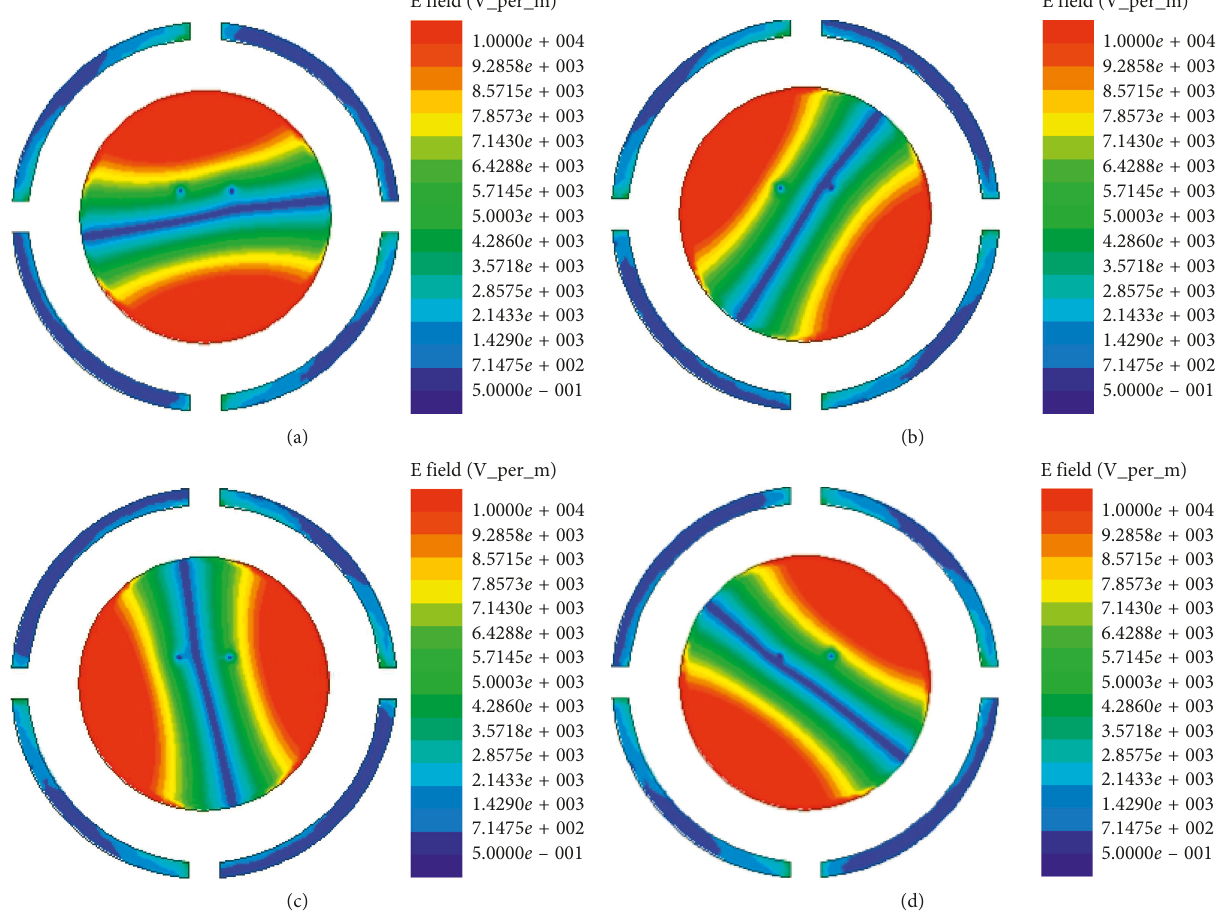
Figure 4: The current distributions over the antenna with the APMS at 1.561 GHz. (a) t � 0. (b) t � T /8. (c) t � T /4. (d) t � 3 T